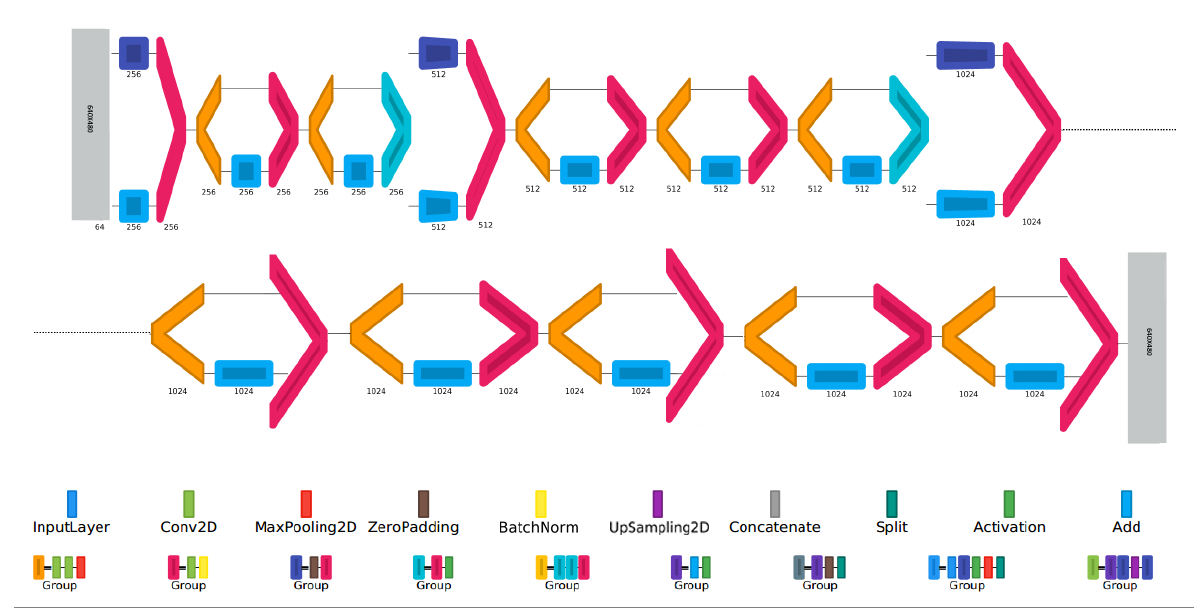
Figure 8. ResNet–UNet for vein